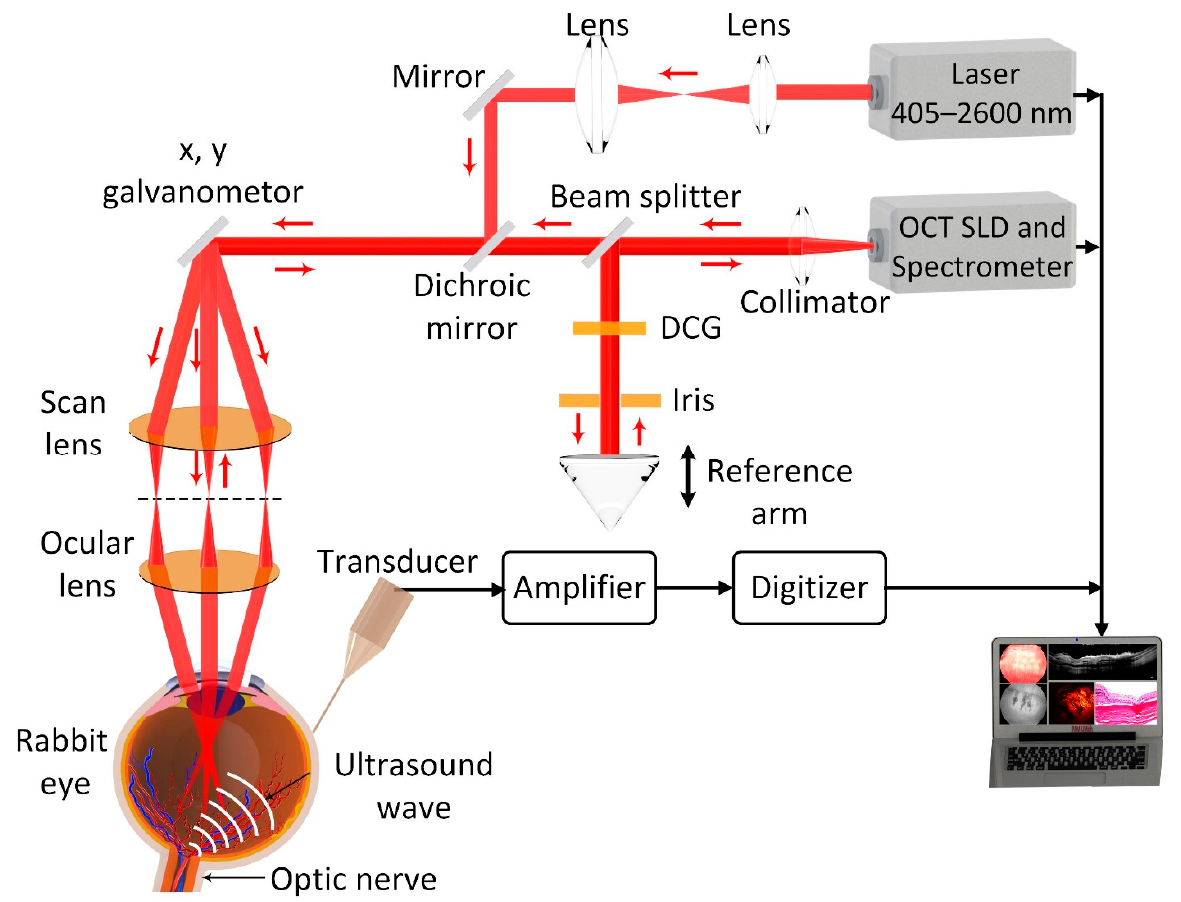
Figure 1. Schematic of the multimodal photoacoustic microscopy and optical coherence tomogra- phy imaging system. DCG: dispersion compensation glass. SLD: superluminescent